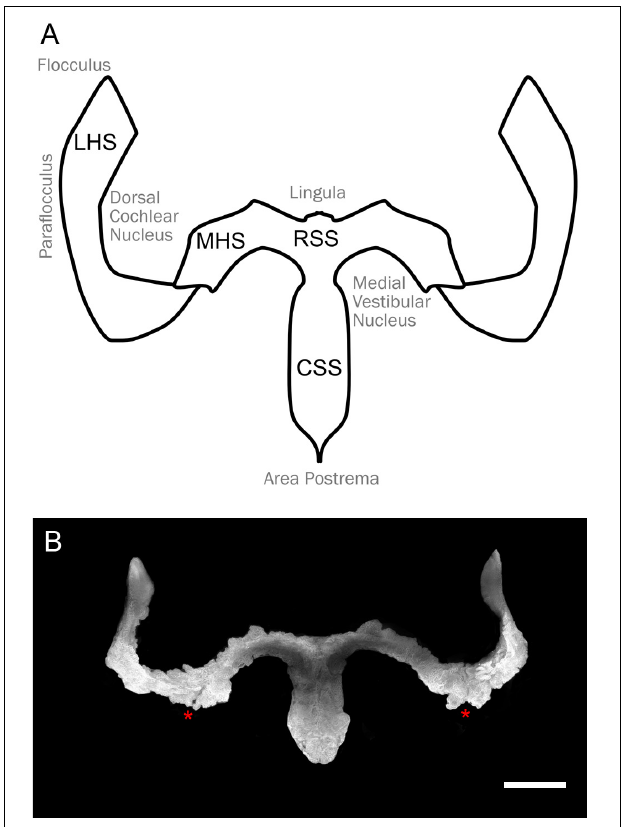
FIGURE 1 | Overall shape of the hindbrain CP. (A) Schema of the hindbrain CP with relative hindbrain surrounding areas. RSS, rostral sagittal segment; CSS, caudal sagittal segment; MHS, medial horizontal segment; LHS, lateral horizontal segment. (B) Overall CP shape obtained from segmentation of the Notch2 signal Z-stack maximal projection of the light-sheet 3D dataset of a female rat cleared brain. Notice the presence of an incisure between MHS and LHS (asterisks). Scale bar: 1